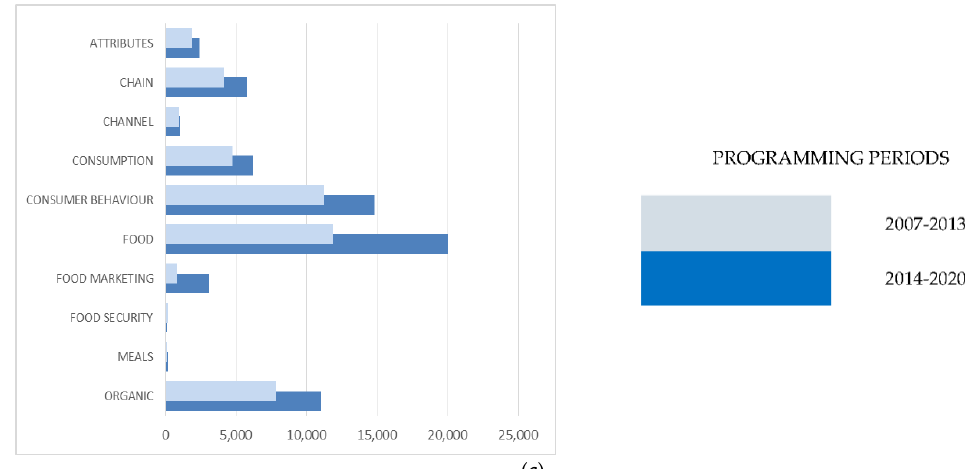
Figure 2. Frequency of each category in the programming periods ( a ) Health categories ( b ) Nutrition categories ( c ) Food categories.